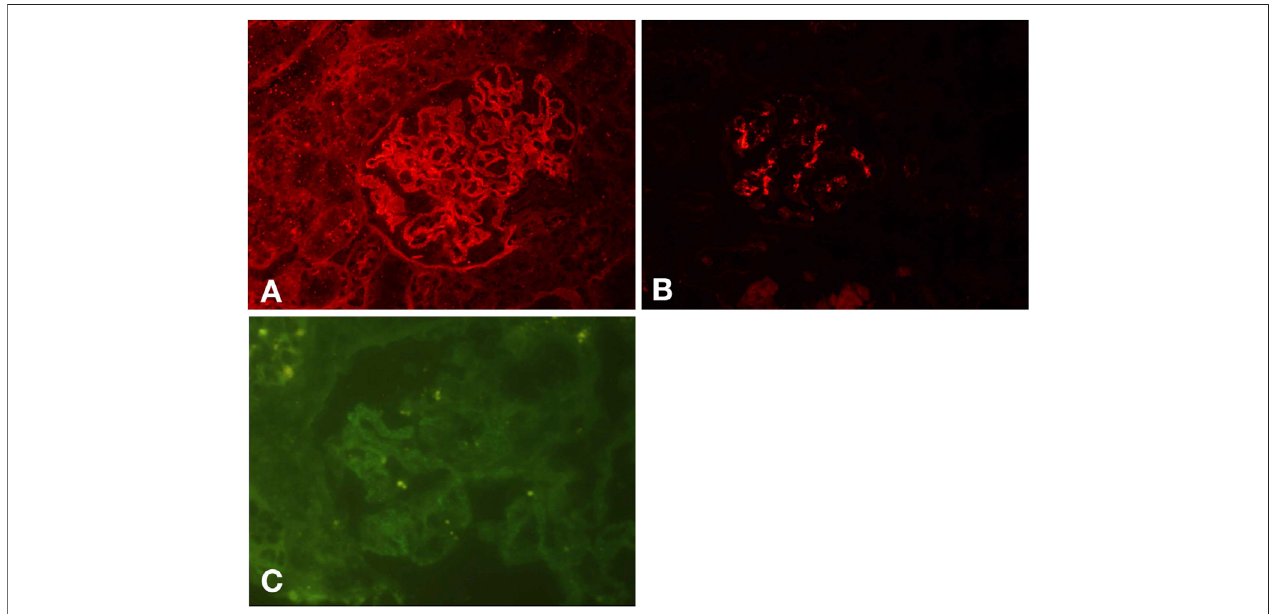
FIGURE2| IFresults. FinegranulardepositionofIgGalongglomerularcapillarywallsandsegmentalwhileweakline-likechangeareasofsomeglomerularcapillary wallandglomerularcapsulewallduetoIgG (A) .LumpydepositionofIgAinthemesangialarea (B) .FinegranulardepositionofPLA2Ralongglomerularcapillarywalls (C) .